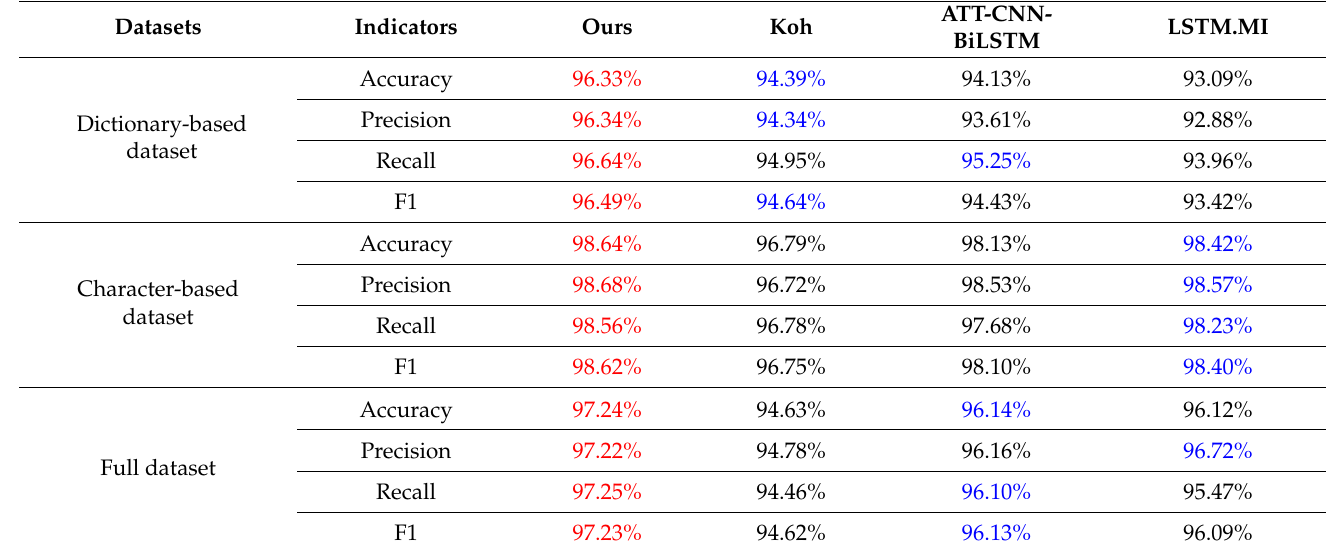
Table 3. Performance of comparison